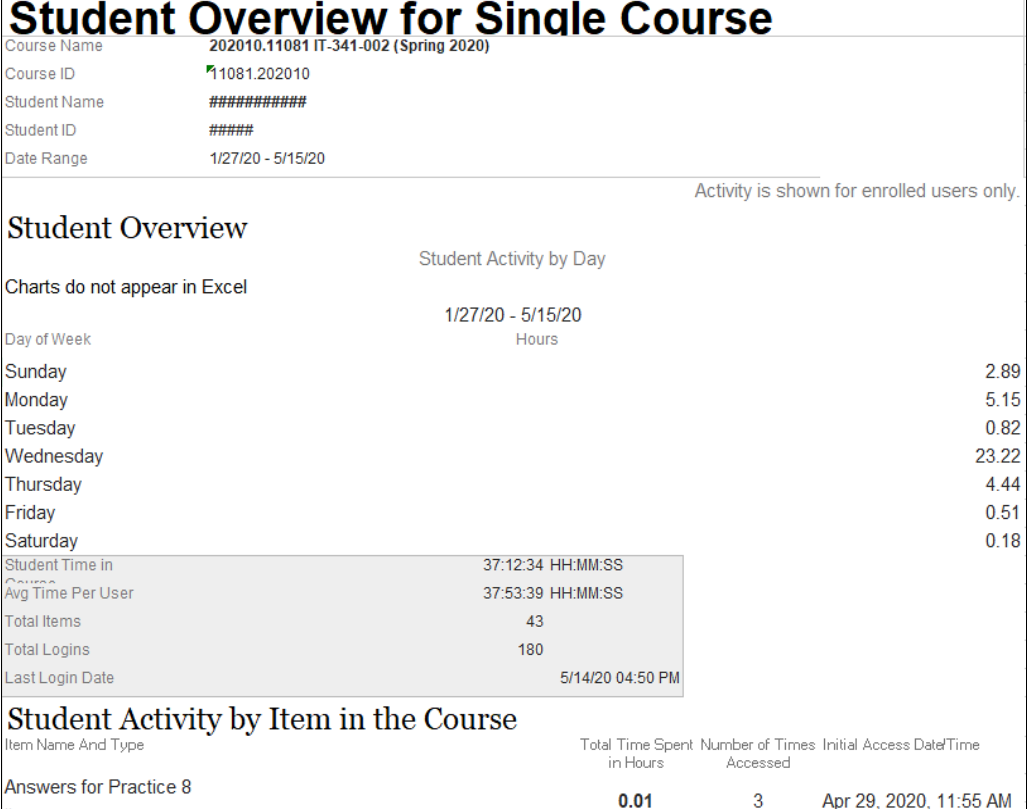
Figure 2. Snapshot of a student Excel file